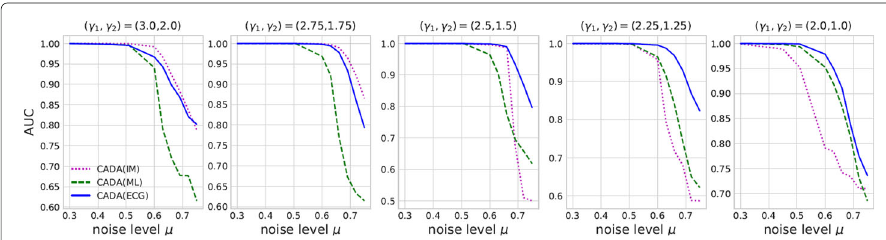
Fig. 10 We compare three flavours of the CADA algorithm using InfoMap (IM), Louvain (ML) and ECG. For each value of .3 ≤ μ ≤ .75, we generated 10 LFR graphs of size 22,186, along with 200 random anomalous nodes with the same degree distribution. We considered 5 different choices for the LFR power law exponents. Results are compared via the area under the ROC curve